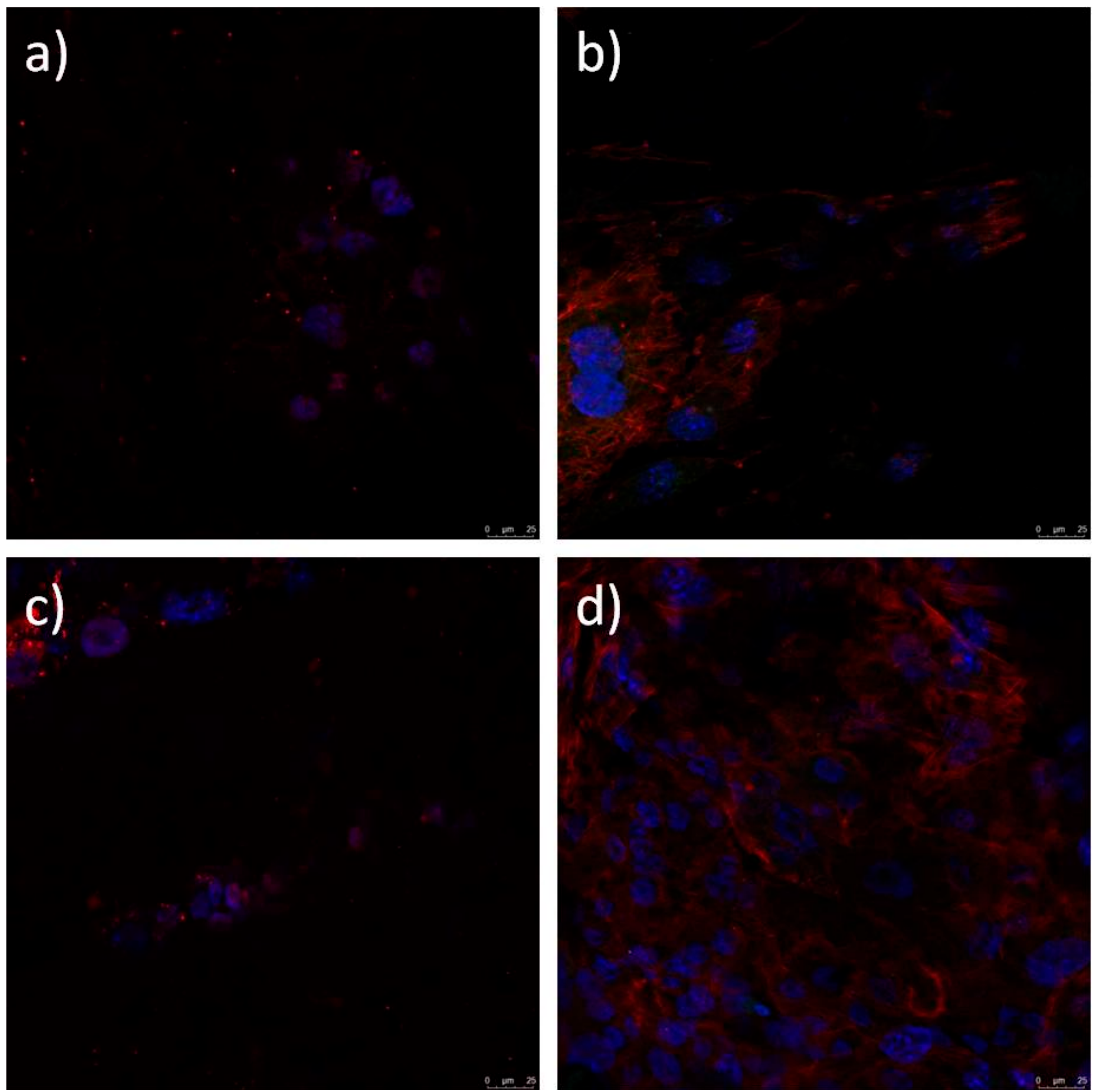
Figure 18. Immunofluorescence analysis of limbal stem cells cultured on PCL/n-TiO 2 ( a , b ) and PCL/m-TiO 2 ( c , d ) scaffold. Cells stained against cornea marker CK3 have cytoplasm coloured with red ( a , c ). Cell stained against stem cell marker p63 show nuclei stained with turquoise. Cytoskeleton is stained red with phalloidin-tetramethylrhodamine B isothiocyanate (TRITC) ( b , d ). All nuclei are counterstained with blue stain 4 ′ ,6-diamidino-2-phenylindole (DAPI).